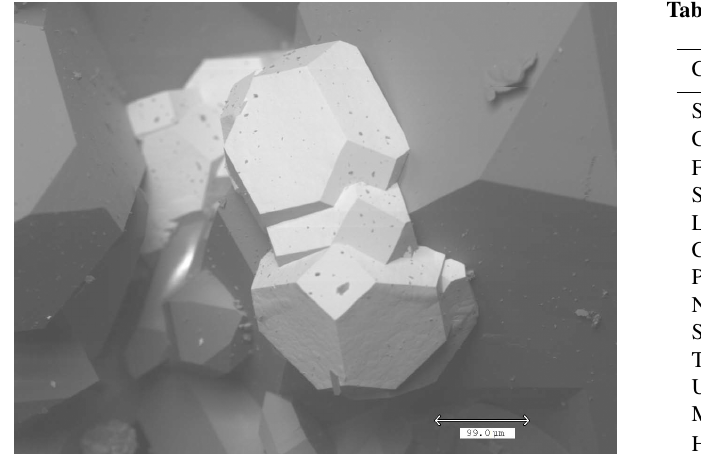
Figure 1. SEM photograph showing truncated octahedra of tancaite-(Ce).